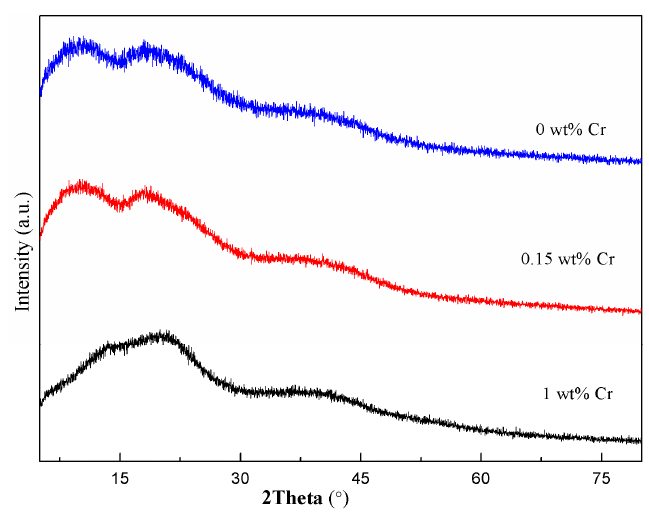
Figure 1. X-ray di ff raction (XRD) spectra of the dry gel with di ff erent amounts of Cr 2 O 3 doping. Figure 1. X-ray diffraction (XRD) spectra of the dry gel with different amounts of Cr 2 O 3 doping.